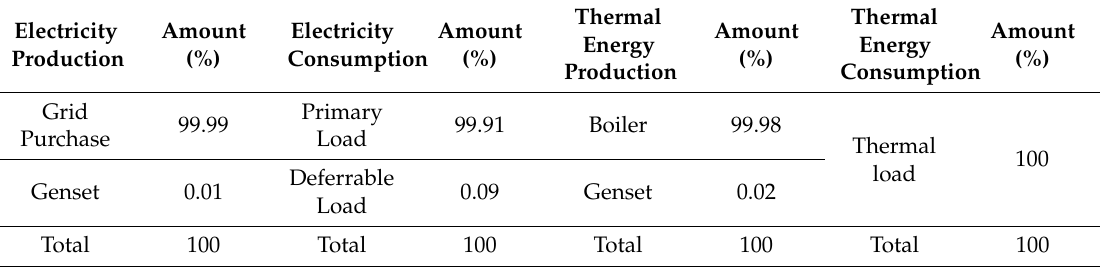
Table 8. Energy production and consumption scenario of grid-connected mode for the first year of project life (case-01).